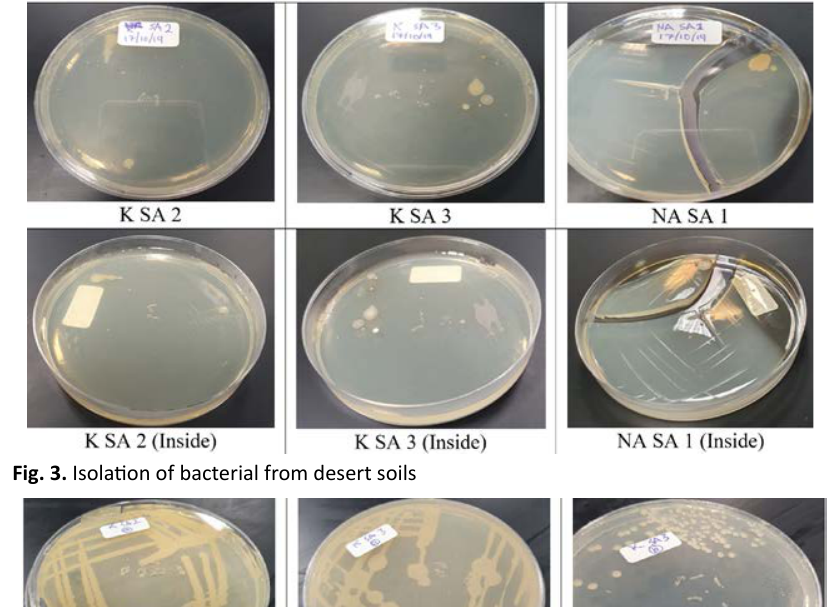
Fig. 3. Isolation of bacterial from desert soils